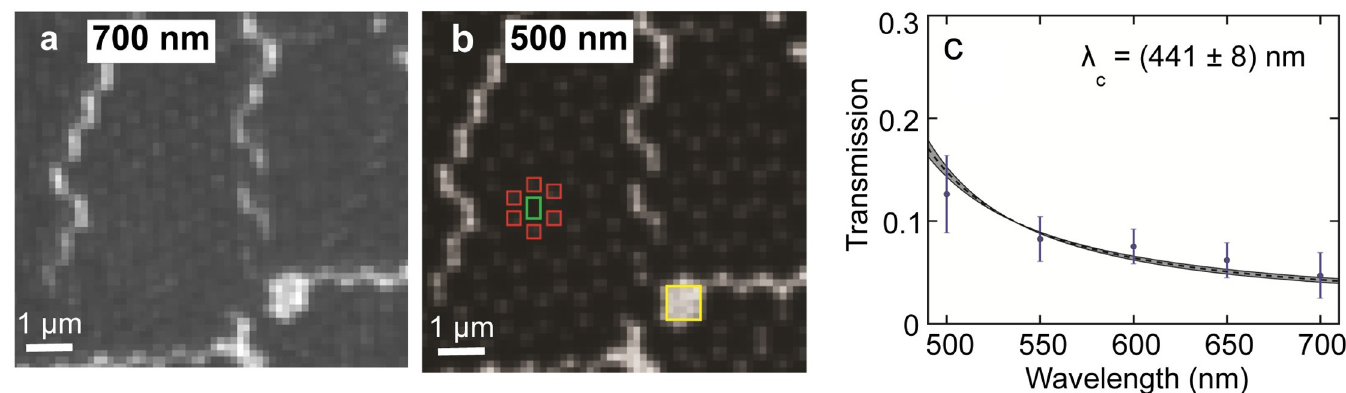
Fig 4. Transmission from back-illuminated guides. Slide back-illuminated with 700 nm light (a) and 500 nm light (b) . Intensity data was collected from sets of 2x2 pixel areas centered on the guides (red boxes). The background level was collected from a box centered in the dark region between guides (green box). Unattenuated light intensity was collected from the closest large defect (yellow box). (c) Transmission data vs. Wavelength; error bars are s.d. from measurements of multiple wells (N = 18). The model function was fit to the data as described in Methods. The grey ribbon corresponds to the uncertainty in the metal thickness z.